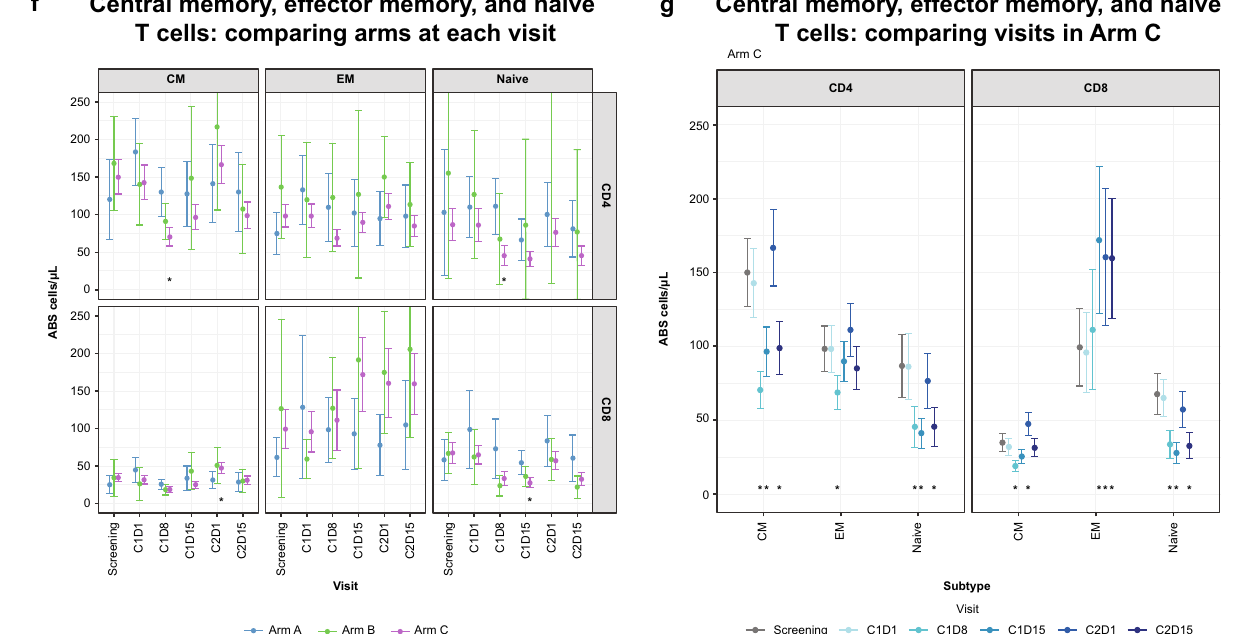
Figure 2. Changes in immune cell subsets in peripheral blood using flow cytometry during treatment with durvalumab monotherapy (Arm A), durvalumab + pomalidomide (Arm B), or durvalumab + pomalidomide + dexamethasone (Arm C). ( a ) CD4 T-cell proliferation; ( b ) CD8 T-cell proliferation; ( c ) NK-cell proliferation; ( d ) CD4 + ICOS + ; ( e ) CD8 + ICOS + ; ( f ) and ( g ) central memory (CM), effector memory (EM), and naive T cells: comparing arms at each visit ( f ) and comparing visits in Arm C ( g ). Asterisks in a-e indicate that Arm C has a nonoverlapping SEM intervals with Arm A and/or Arm B. Asterisks in f show where there is a non-overlapping interval in Arm C versus Arm A. Asterisks in g show which visits are changed (nonoverlapping interval) from the baseline (screening/C1D1) visits. ABS, antibodies; CM, central memory; EM, effector memory; ICOS, inducible T-cell co-stimulator; NK, natural killer; POM, pomalidomide; SEM, standard error of the